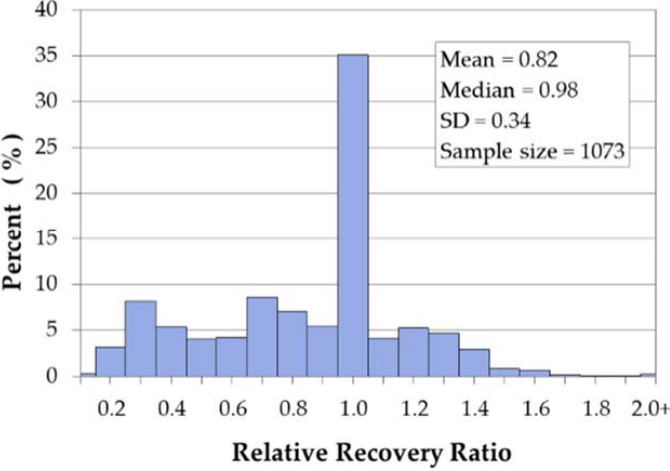
Figure 2. Histogram for RRR values.